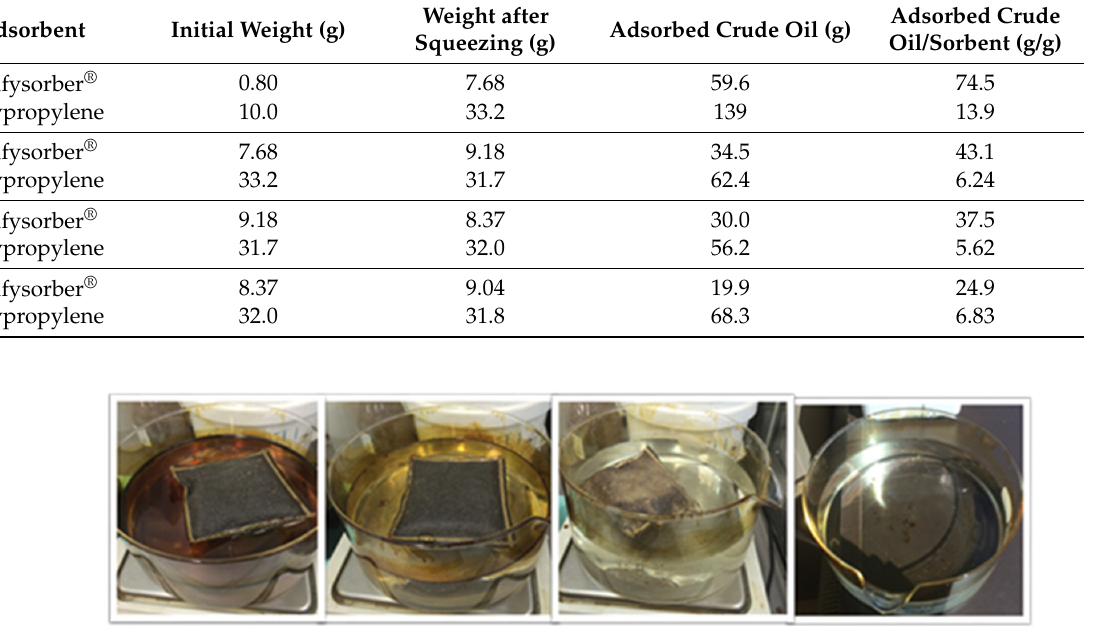
Figure 10. Adsorption sequence related to test n.2 (with 1 cm of oil) using Grafysorber ® G+ with crude oil. Evolution over time from left to right. Table 4. Crude oil adsorption tests with Grafysorber ® G+ and Polypropylene.